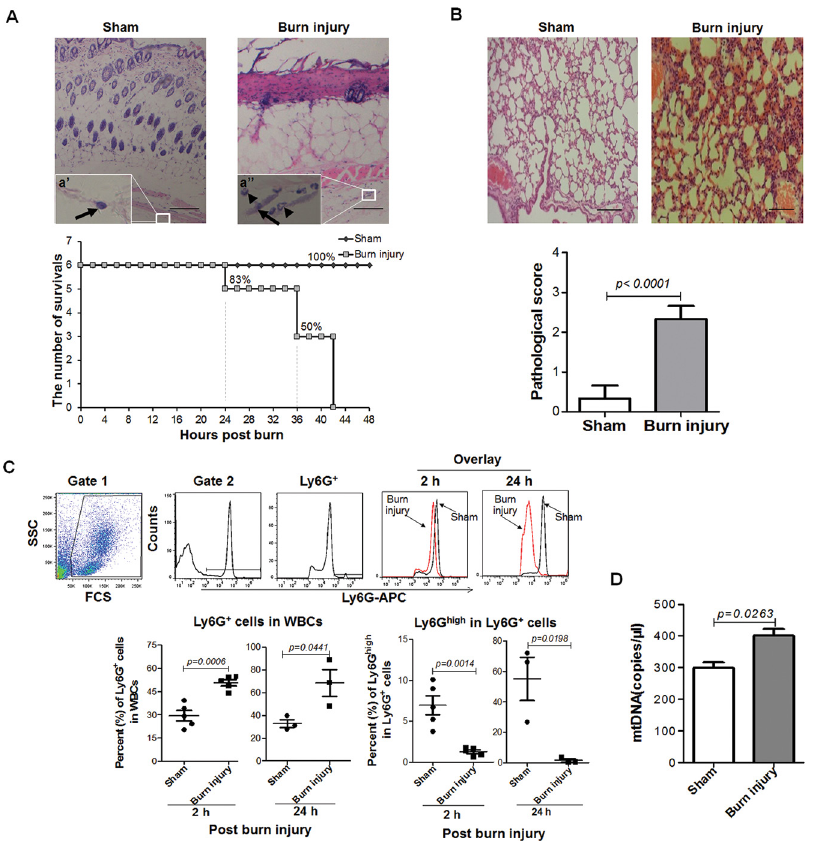
Figure 1. Sterile systemic inflammatory responses induced by skin burn injury in mice. Female BALB/c mice (n = 6 mice/group) were burned with electrocautery at 400–430°C for 3 s and their survival was recorded. The skin and lung tissues of burn-injured mice and normal mice were collected at 24 h post burn for histological analysis. (A) Skin patho- logical changes (hematoxylin and eosin [H&E] staining, magnification x 40) and survival curves of mice. (a’) and (a’’) Higher magnification (x 400) of fibroblasts, denoted by arrows, and neutrophils, denoted by arrowheads, in muscular fascia. Scale bars = 200 μ m. (B) Lung pathological changes (H&E staining, magnification x 40) and scores. Scale bars = 200 μ m. (C) Ratios of Ly6G + cells in WBCs and Ly6G high in Ly6G + cells. Ly6G + cells represent the neutrophils. Data are represented as mean ± standard error of the mean (SEM) (n = 3–5 mice/group). (D) The mtDNA copies in plasma of sham or burn-injured mice were detected by qPCR. Data are represented as mean ± SEM (n = 3